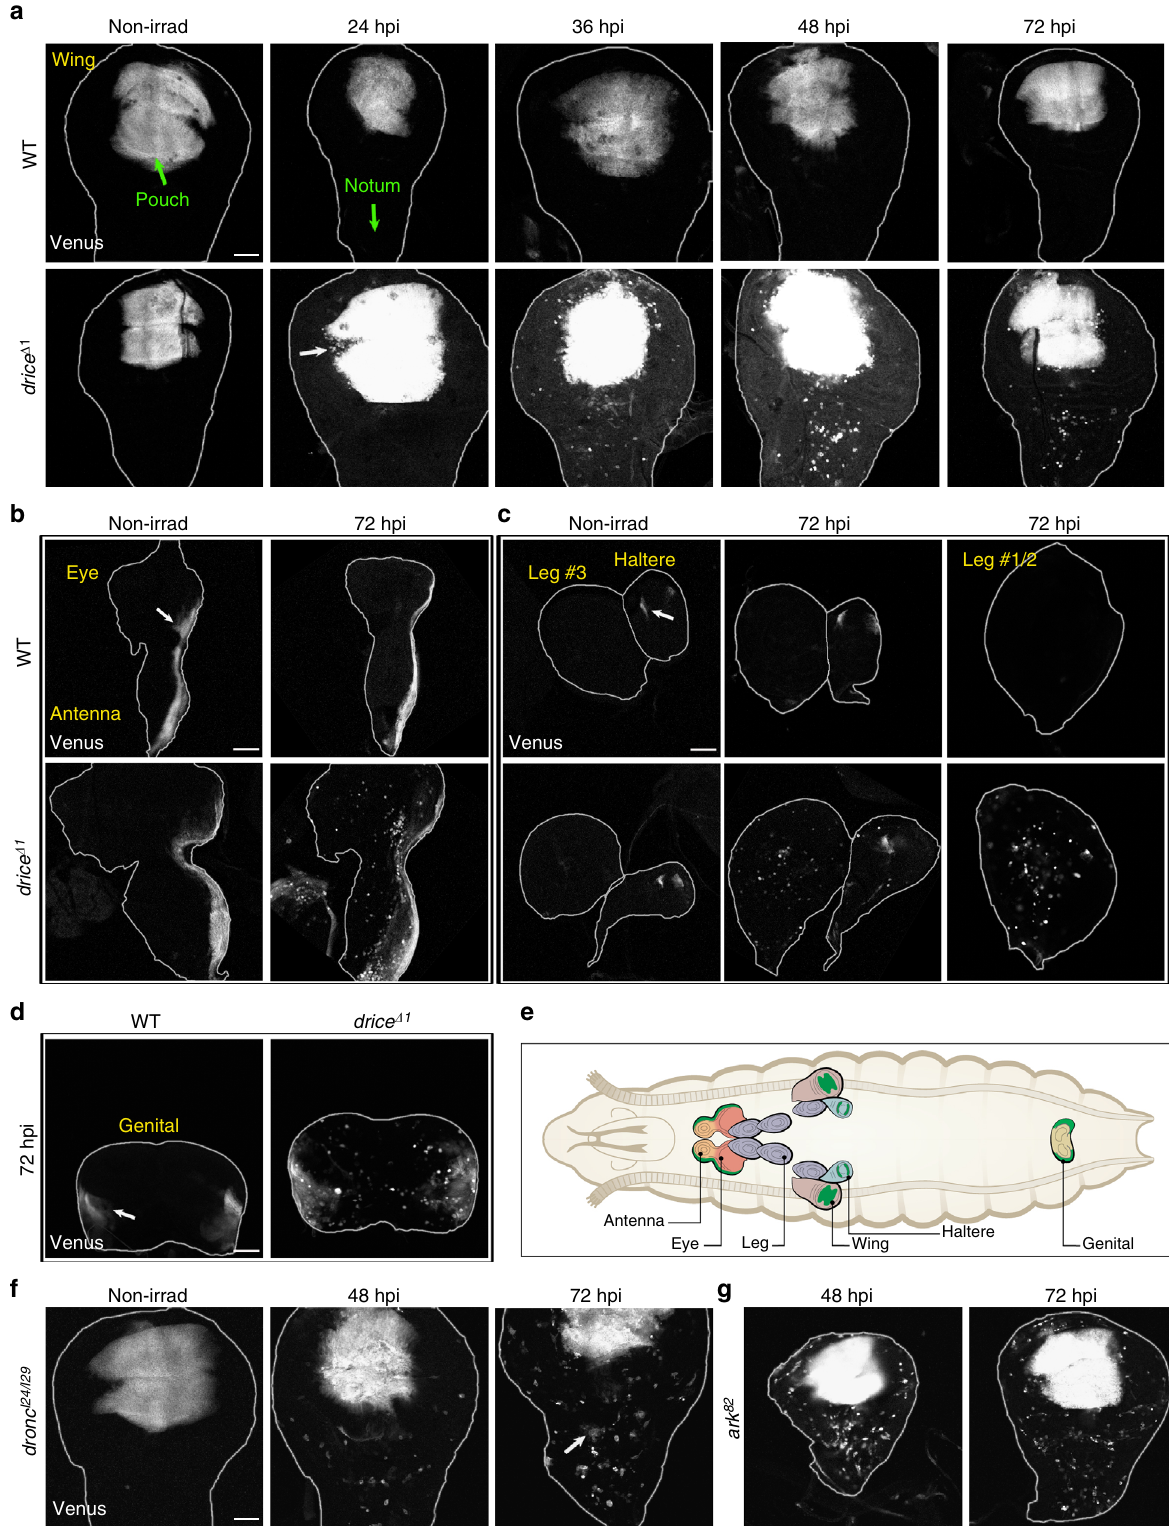
Fig. 2 Irradiated epithelial cells compromised for caspase activity acquire migration capacity. a ICM is induced in irradiated (50 Gy) WDs where the major effector caspase Drice is completely inactivated, but not in irradiated WT WDs and non-irradiated WDs, starting at 24 hpi (white arrow) and peaking at 48 hpi. b – d ICM is induced in all the indicated irradiated (50 Gy) imaginal discs, including the leg discs ( c ) where sal -Gal4 is not expressed. Arrows indicate the sal -Gal4 expression regions. e Illustration of a Drosophila larva and the examined imaginal discs. The corresponding sal -Gal4 expression regions are indicated in green. f , g Inactivation of the apoptosome components can induce ICM. Irradiated dronc I24/I29 ( f ) and ark 82 ( g ) mutant WDs (50 Gy) display multiple migrating cells, some of which are in clusters (arrow). Scale bars, 50 µ